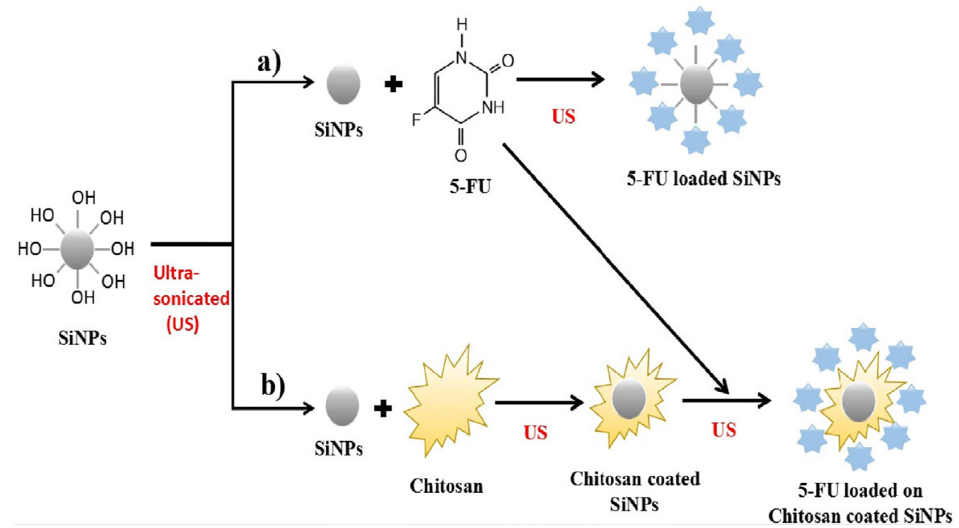
Figure 6. Schematic of the functionalization of 5-FU on SiNPs by ( a ) Direct conjugation (SiNPs conjugated with 5-FU) and ( b ) indirect conjugation (chitosan-coated SiNPs conjugated with 5-FU). Reprinted with permission from Ref. [31]. Copyright 2020, Elsevier.